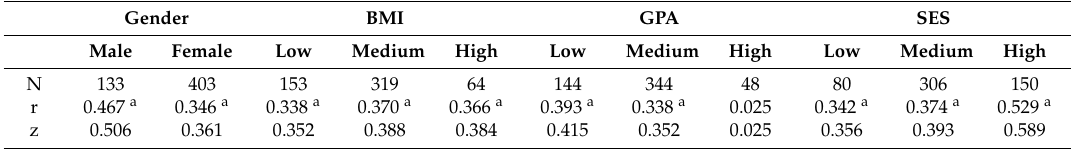
Table 6. Pearson’s product-moment correlation and z-score of perceived PL and PA level in each factor ( n = 536). Gender BMI GPA